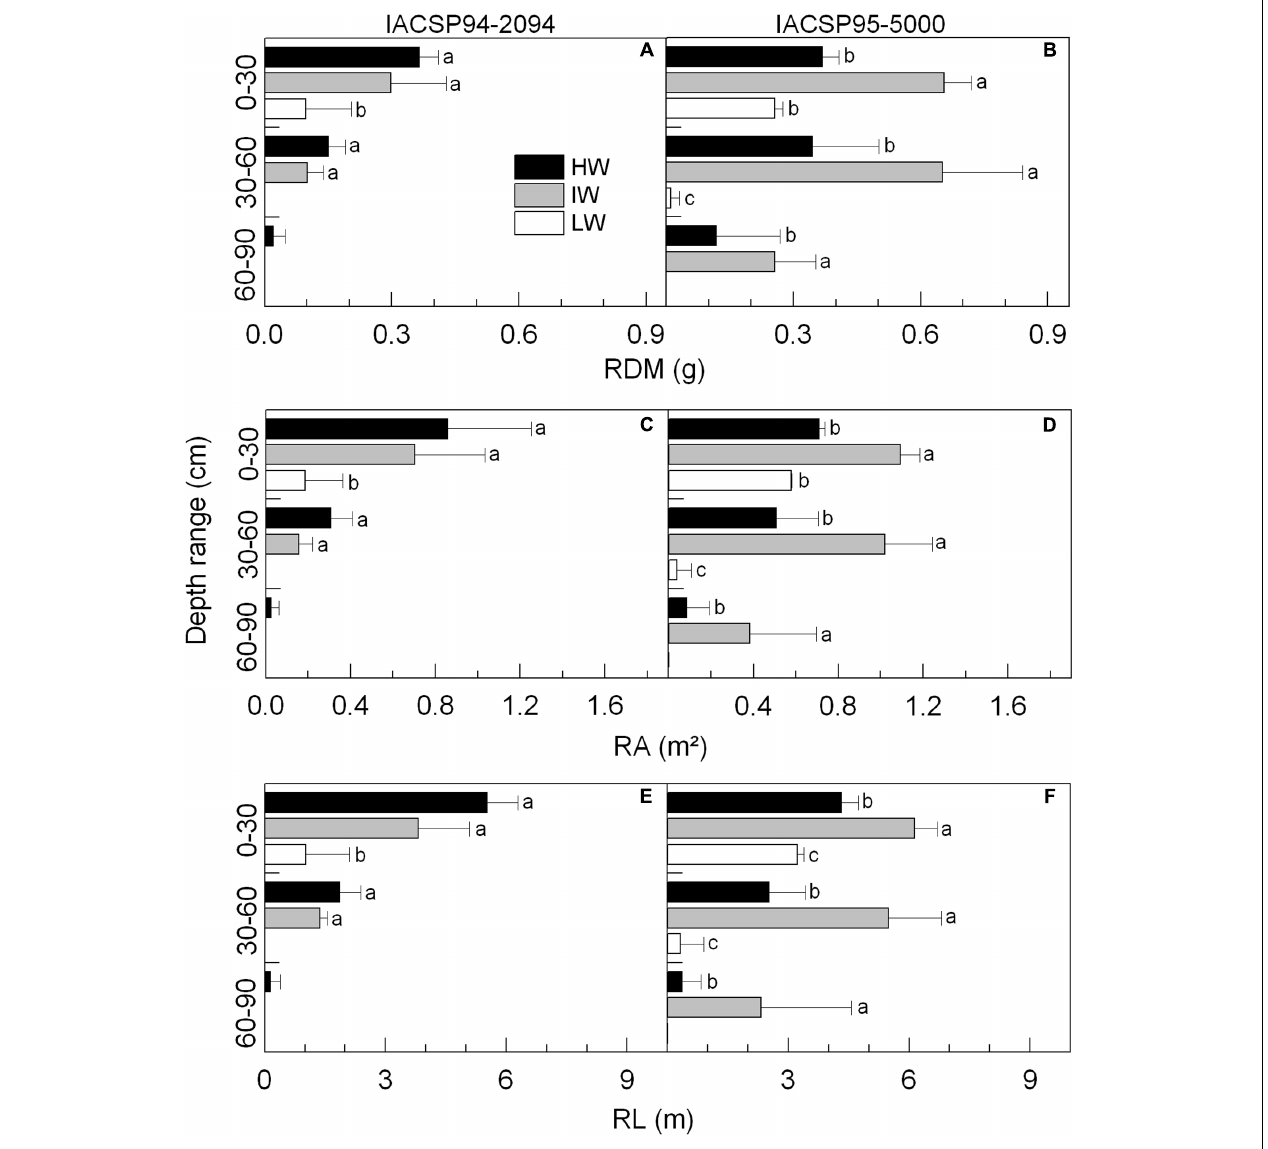
FIGURE 5 | Soil profiles of root dry mass (RDM, in A,B ), root area (RA, in C,D ) and root length (RL, in E,F ) in sugarcane varieties IACSP94-2094 (in A,C,E ) and IACSP95-5000 (in B,D,F ) exposed to high (HW, black), intermediate (IW, light gray), and low (LW, white) water availability. Bars indicate the mean value ( n = 3) + SD. Lowercase letters compare water regimes (Student’s t , p < 0.05) in a given variety and soil